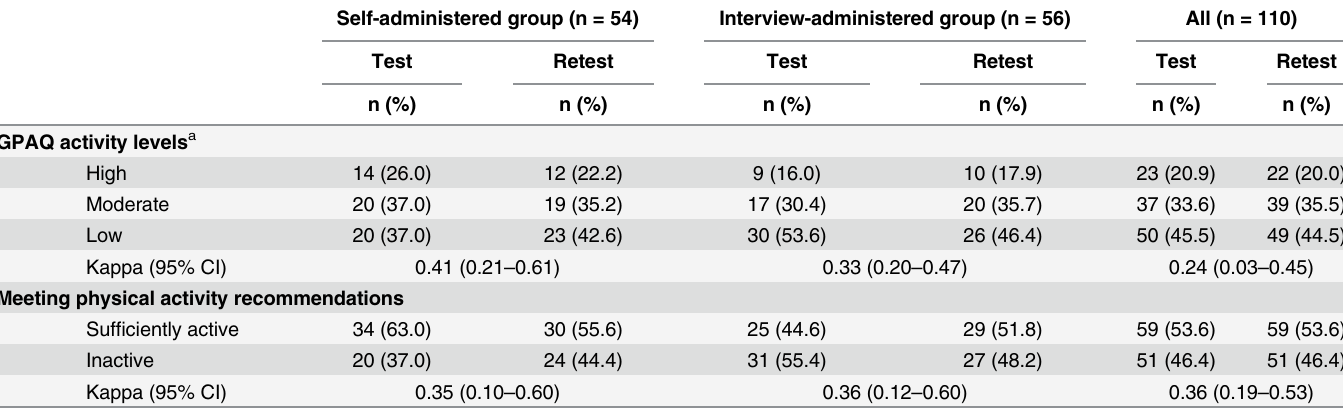
Table 3. Proportion of participants according to the GPAQ classification of meeting recommended physical activity levels (low, moderate, high) by self- and interviewer-administered groups (n = 110).